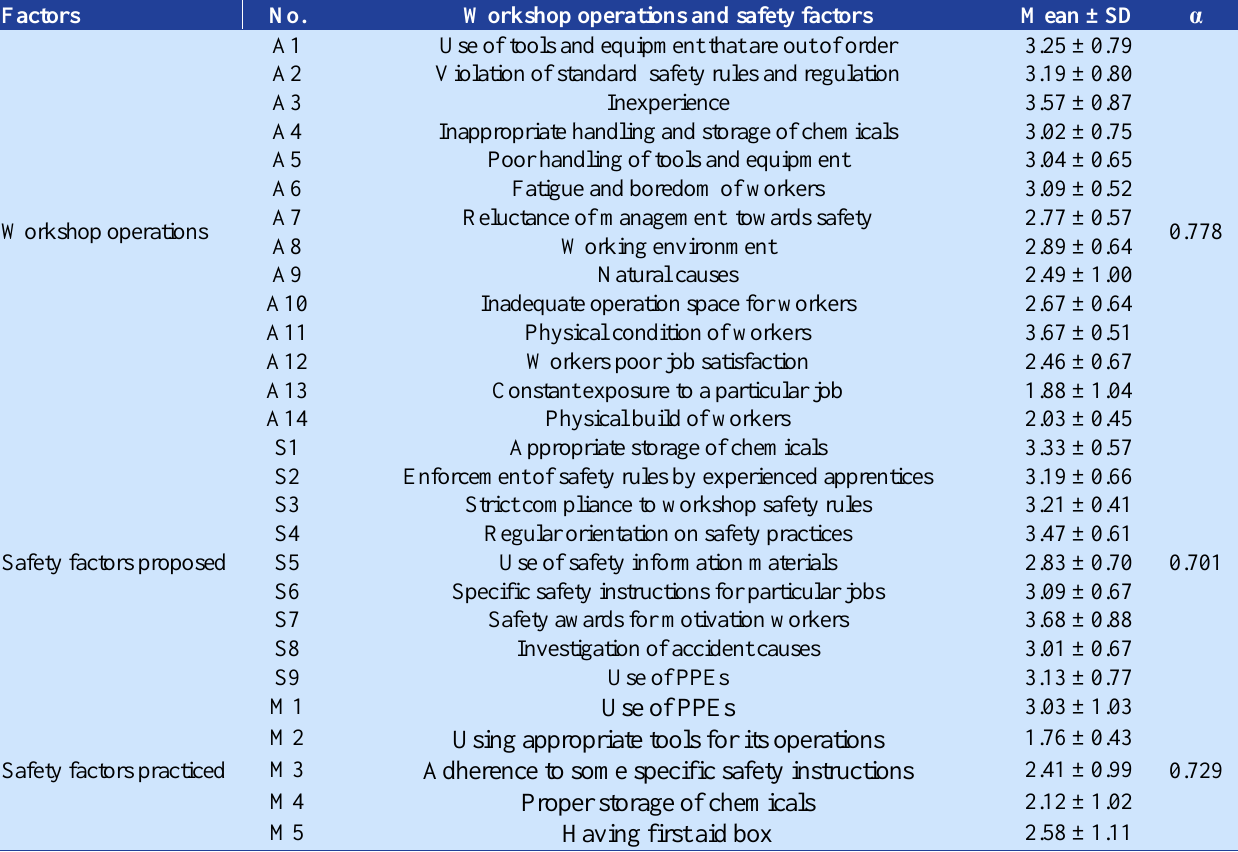
Table 3. Descriptive analysis of potential accident causing workshop operations, safety factors proposed and practiced by respondents